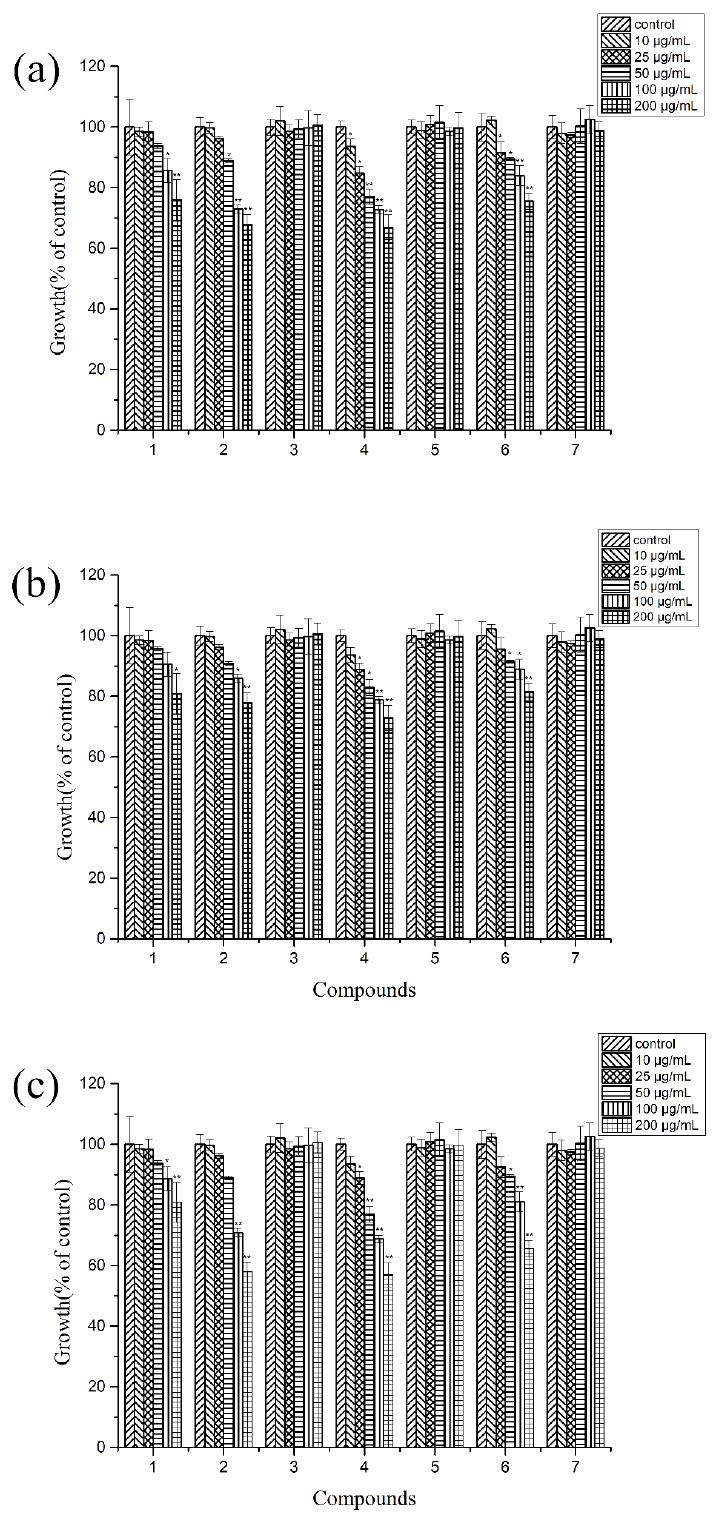
Figure 4. Autotoxic effects of compounds 1 – 7 on the height of the seedlings ( a ), the fresh weight of the leaves and stems ( b ), and the fresh weight of the roots ( c ) at concentrations of 10, 25, 50, 100, and 200 µ g/mL, respectively. Values are presented as a percentage of the mean compared to the control. Means significantly lower than the DMSO controls are indicated by * (one way ANOVA; p < 0.05) or ** ( p < 0.01). Error bars are one standard error of the mean. n = 3.